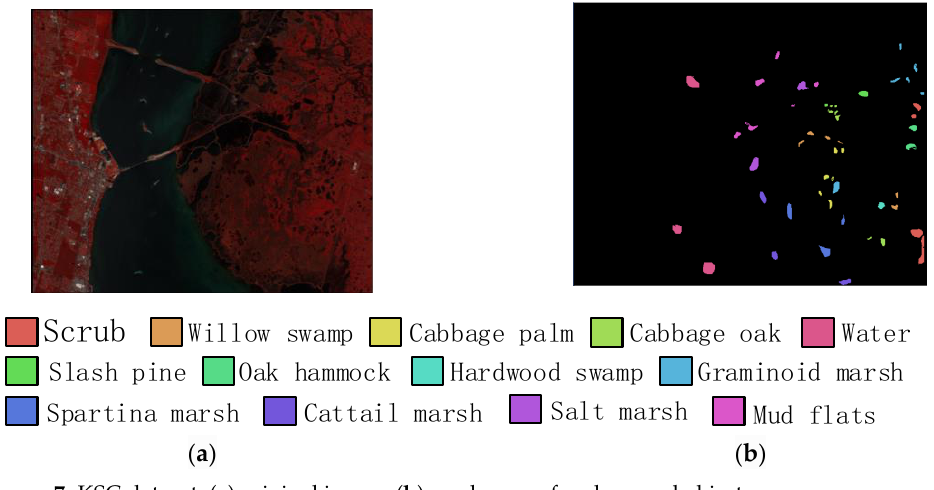
Figure 7. KSC dataset, ( a ) original image, ( b ) mark map of real ground objects. Table 2. Training validation and testing sample numbers in KSC.